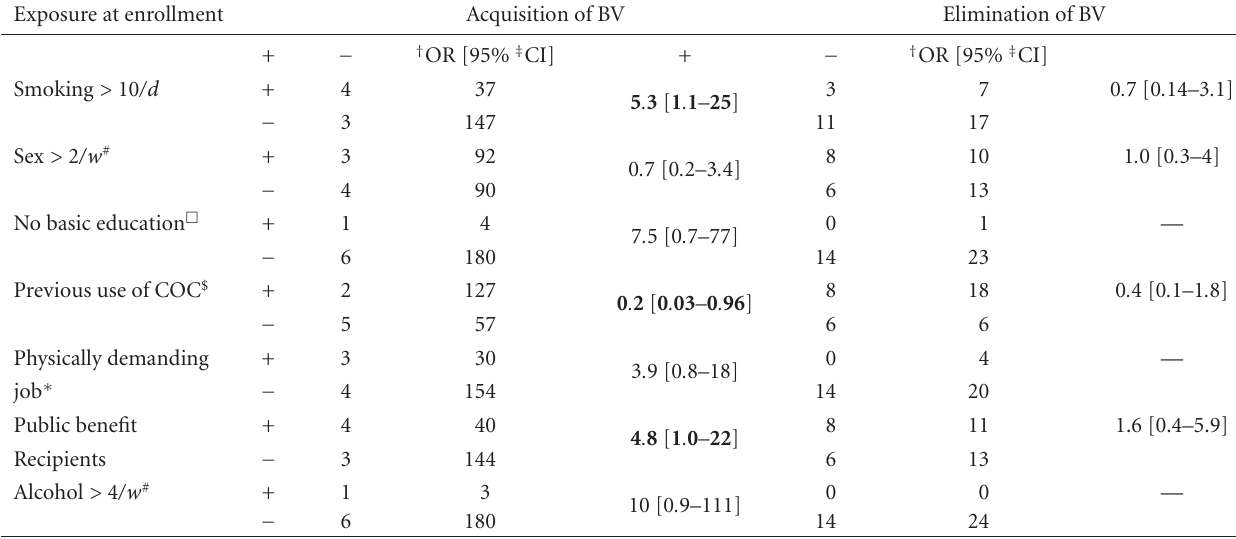
Table 2: Behavioral risk factors for the acquisition or elimination of bacterial vaginosis (Amsel’s criteria) in pregnancy. ( N = 229.) Exposure at enrollment Acquisition of BV Elimination of BV